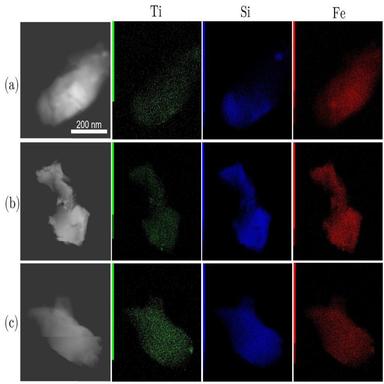
STEM–EDS maps of materials 1–3: (a) material 1 (commercial samples), (b) material 2 (in-house prepared samples sintered at 1400◦C) and (c) material 3 (in-house prepared samples sintered at 1500◦C).